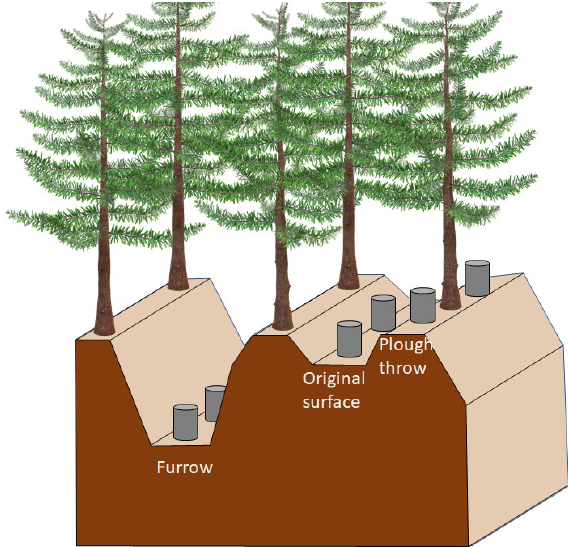
Figure 1. Microtopography in forest plantations, with location of measurements for flux chambers (not to scale).